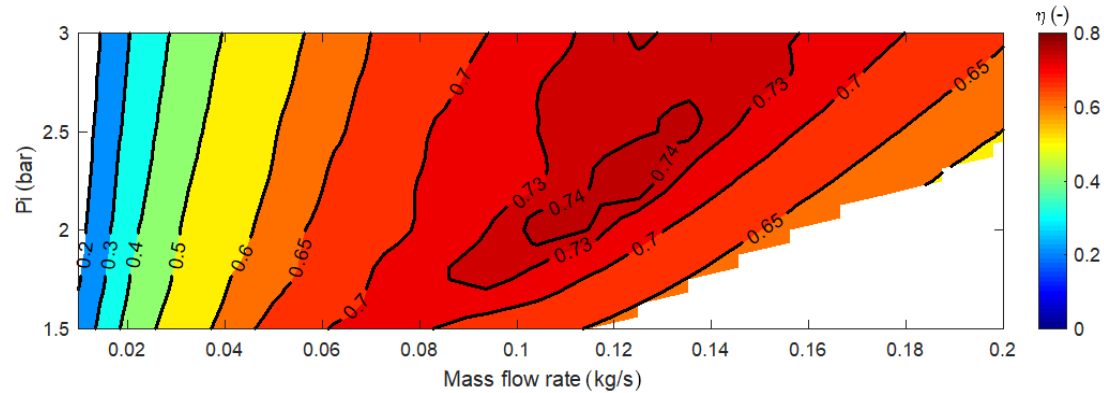
Figure 11. Maximum efficiency map for GL51 twin-screw expander running on air (Ti = 75 °C and Po = 1 bar).